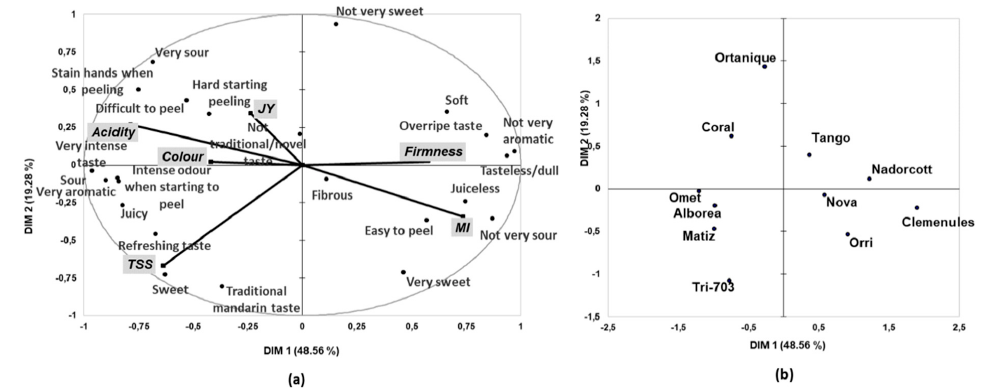
Figure 5. MFA using CATA counts and physico-chemical data of the eleven cultivars under study. ( a ) representation of the sensory attributes and physico-chemical properties on the first two dimensions of the MFA, ( b ) representation of the eleven mandarin cultivars on the first two dimensions of the MFA. DIM—dimension MFA.